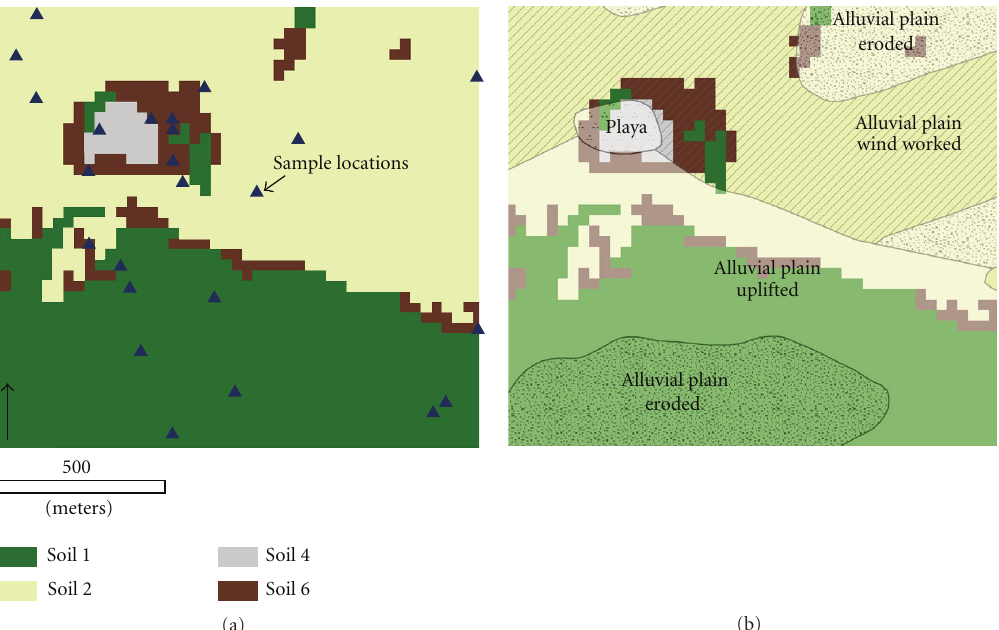
Figure 3: Supervised classificationrepresenting soilclassesfor the 150ha study area onthe ChihuahuanDesert Rangeland Research Center in southern New Mexico. Spectral classes were derived in an automated fashion using the Transformed Divergence feature in ERDAS Imagine. A field assessment of 24 points (blue triangles) was conducted by generating a stratified random sample to characterize soils within mapped classes (a); labels correspond to mapped soil classes. Mapped soil classes are depicted in the context of mapped landforms of the Jornada Basin (b); labels coincide with landforms described by Monger et al. [22].